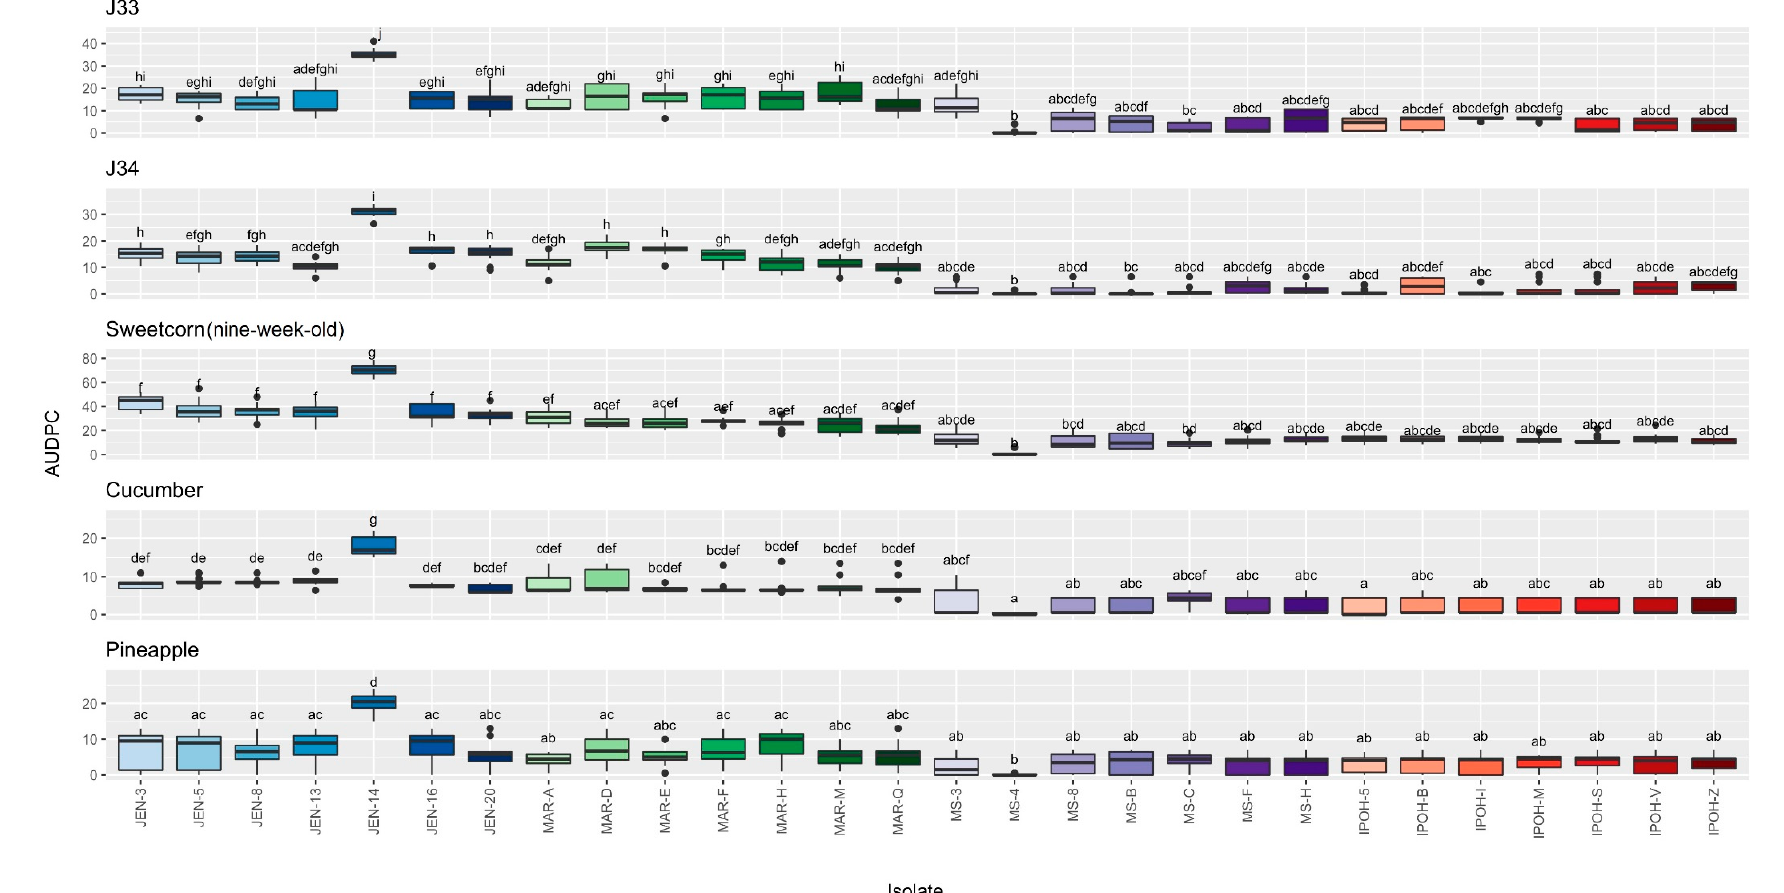
Figure 9. The AUDPC value of disease rating of Pantoea stewartii subspecies stewartii from the inoculation performed on the jackfruit variety Tekam Yellow J33, jackfruit variety Hong J34, sweetcorn (nine weeks old), cucumber, and pineapple was calculated for 14 days post-inoculation. The experiment was repeated three times. The Kruskal–Wallis test was used to carry out statistical analysis, followed by Dunn’s post hoc test for comparisons of rank sums. The ends of boxplot whiskers represent the minimum and maximum values of all the data, and the median is shown as the horizontal black line inside the box. Different letters indicate significant differences between isolates at a 5% significance level. Color ranges are displayed based on collection areas: blue on the Jenderam isolates; green on the Maran isolates; purple on the Muadzam Shah isolates; and red on the Ipoh isolates.